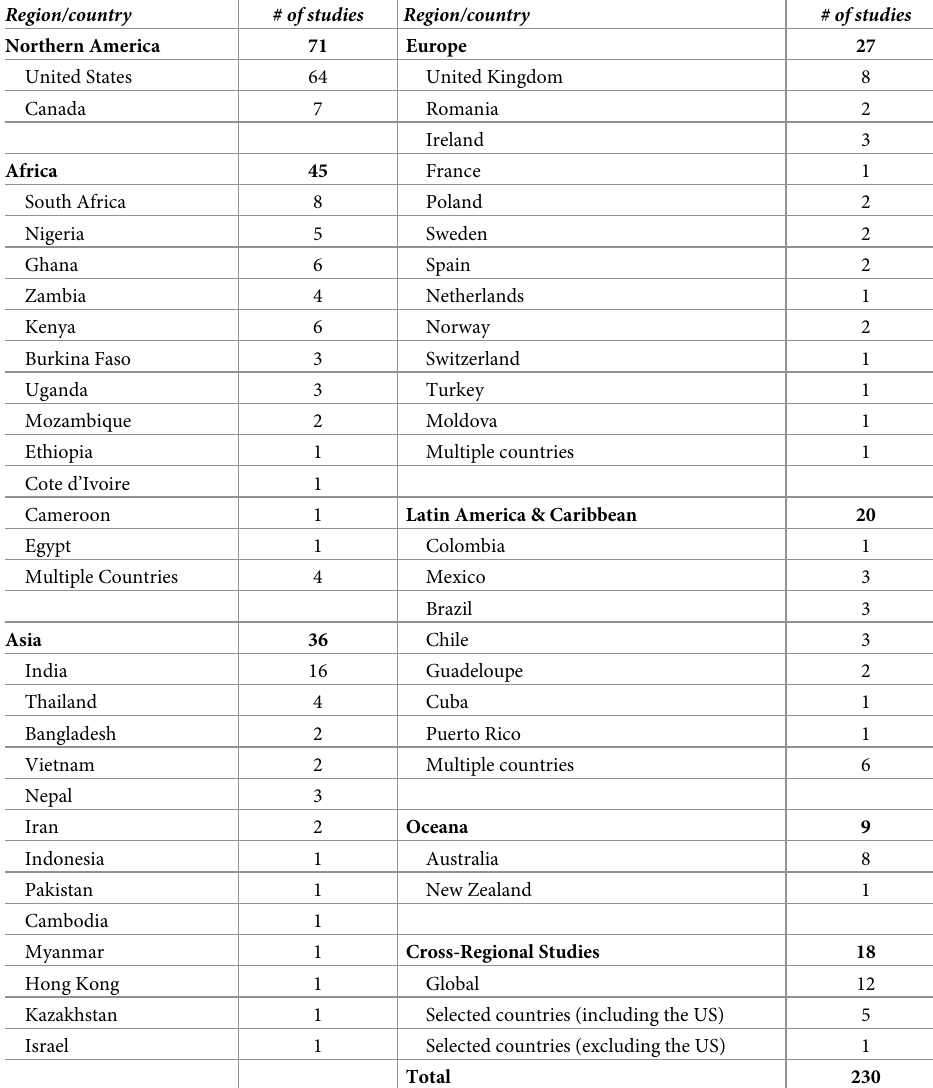
Table 3. Included studies by region and